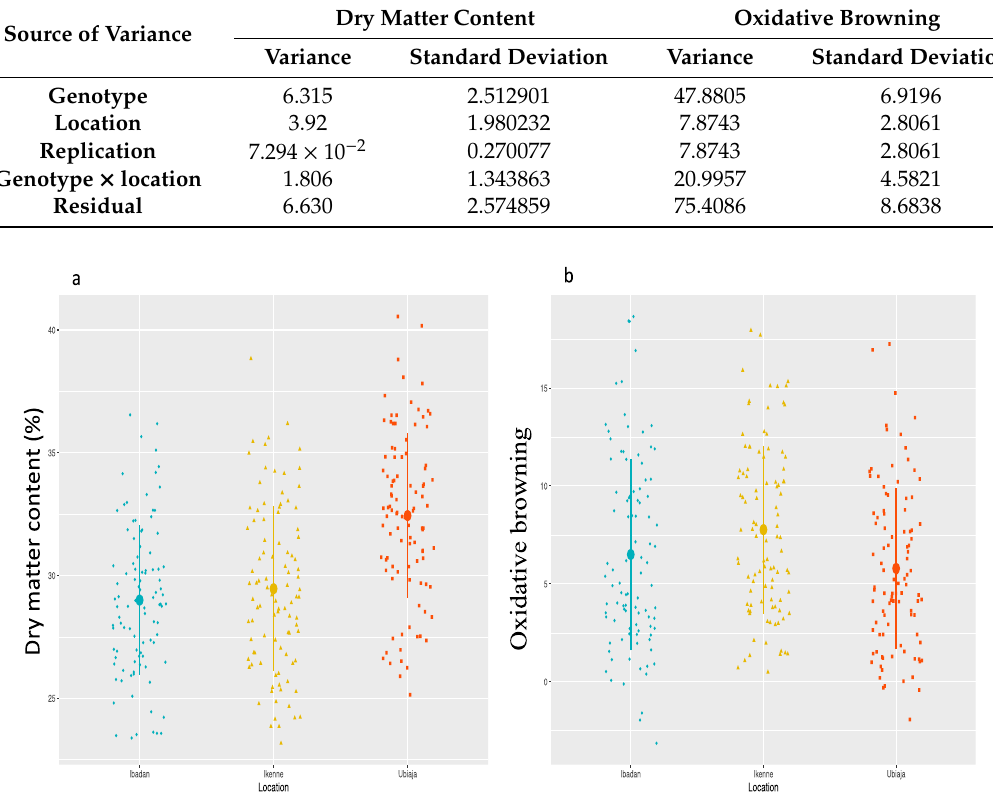
Figure 1. Dot plots for the distributions of tuber dry matter content ( a ) and oxidative browning ( b ) across three locations. The dots represent the clones, while the solid line represents the error bar.